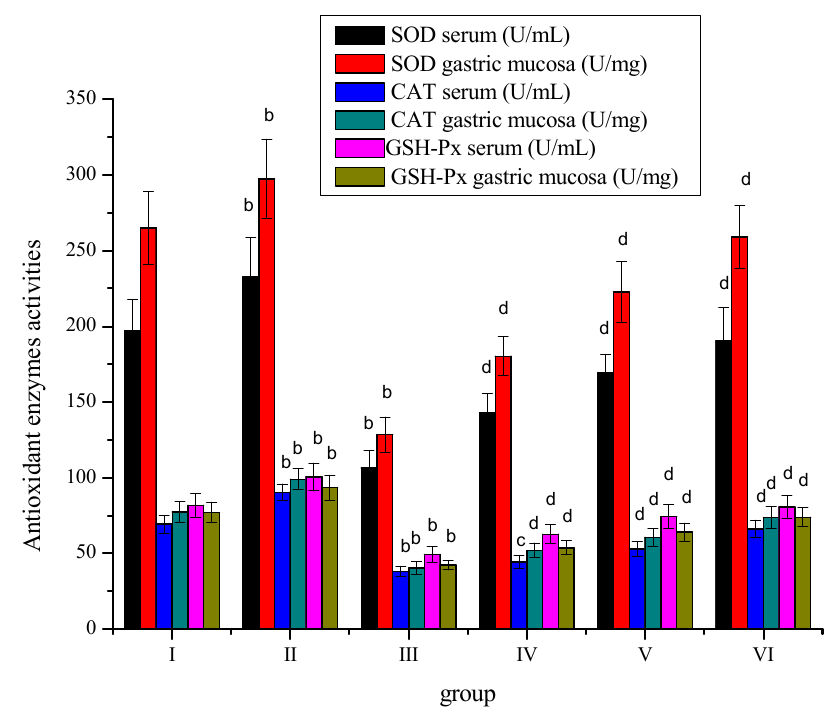
Figure 5. Effect of Sargassum pallidum aqueous extract on serum and gastric mucosa SOD, CAT and GSH-Px in different